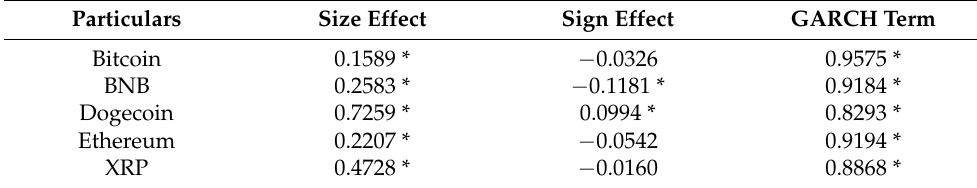
Table 8. Beta Coefficient Analysis of E-GARCH